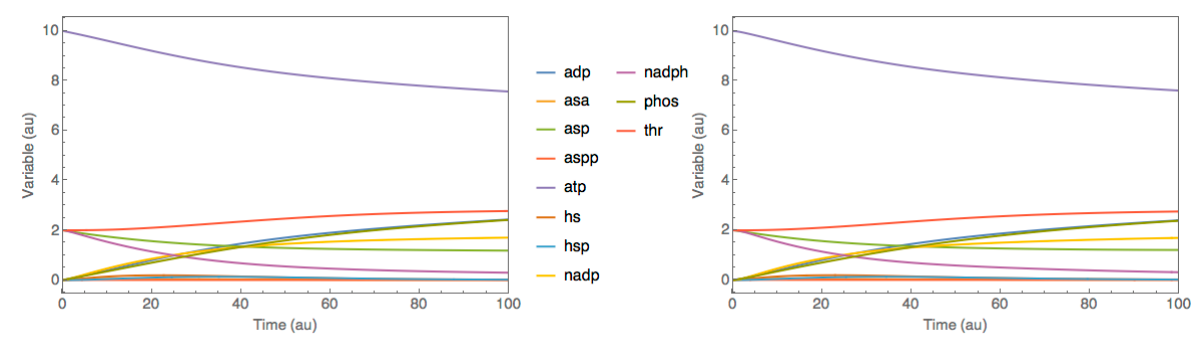
Figure 3. Comparison between original model and best hybrid model for case study 1 (threonine synthesis pathway in E. coli ) Dynamic profiles were simulated based on the respective SBML files in the JWS Online platform. The test experiment was the center point experiment of the CC-DOE (not used for training). Full lines represent species concentrations over time. Left panel: Original SBML model simulation. Right panel: Best hybrid model simulation with structure [11 × 5 × 5 × 7] (First row of Table 2).